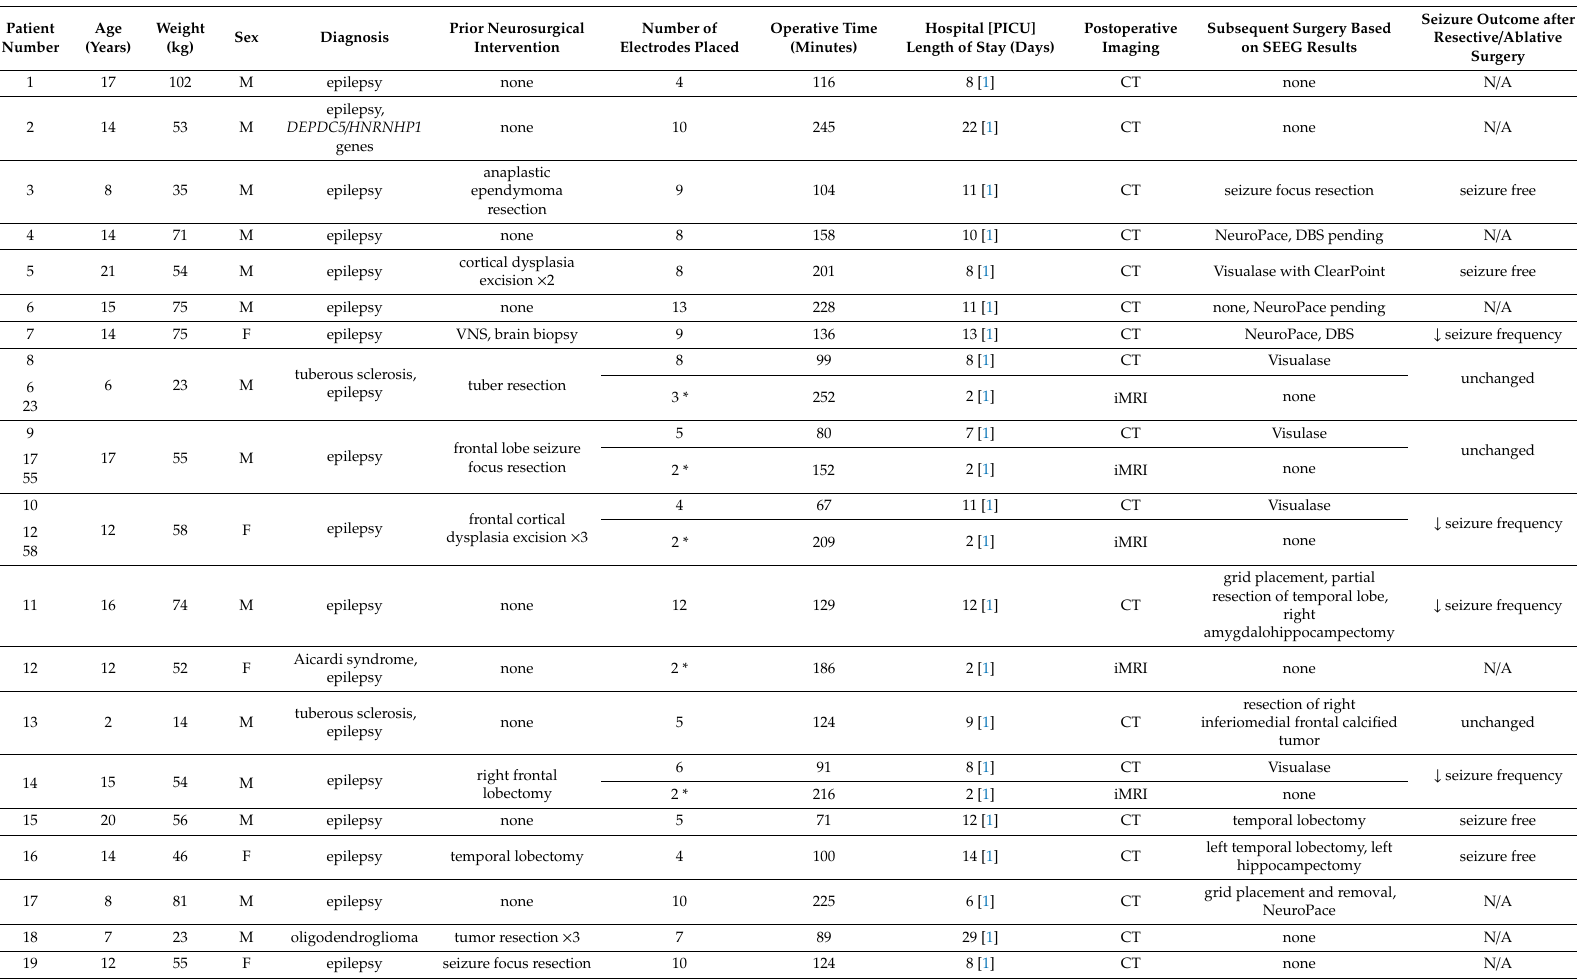
Table 2. Characteristics and surgical outcomes for 23 ROSA ® SEEG procedures in 19 pediatric